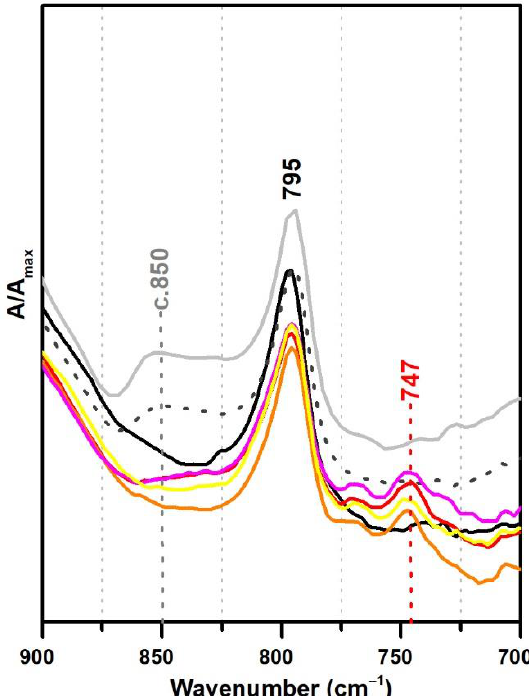
Figure 7. Infrared spectra in ATR spectra of the pure PVAc emulsion (black), PVAc stabilised with 10% PVAl (light grey), Polidisp 1080 (dotted dark grey), Polidisp DM22 (red), Polidisp DM9725 (orange), Polidisp DM 21 (pink), and Polidisp DM23 (yellow). According to technical data sheets, only Polidisp DM21, DM22, DM23, and DM9725 are stabilised with “polymeric compounds”, as referred by the company.